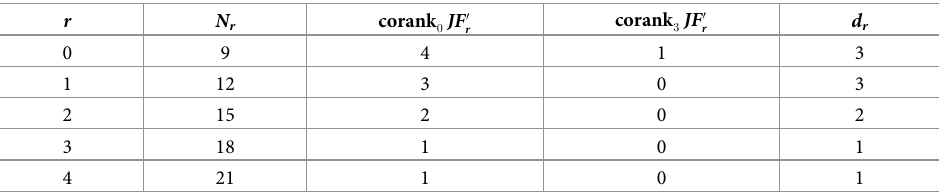
Table 3. Summary of computations showing that (5) is unidentifiable when x 3 (0) =